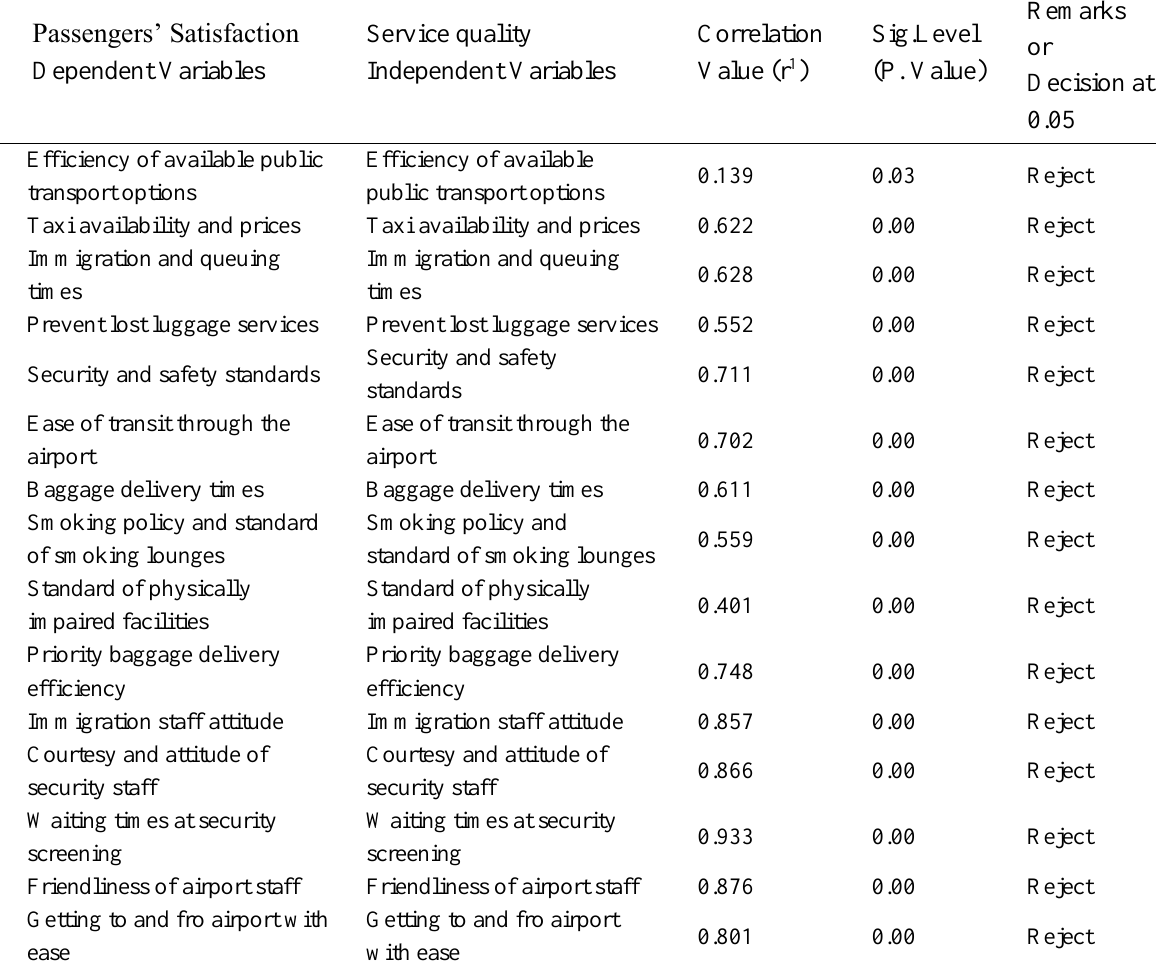
Table 6. Charles Spearman’s Rank Correlation Showing the Relationship between Passenger’s Satisfaction and Service Quality for Disaggregate